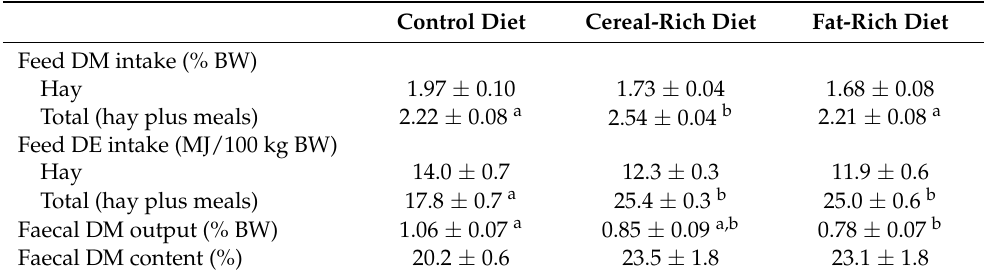
Table 3. Measures of feed intake and faecal output during the 24-h total faecal collection period (mean ± standard